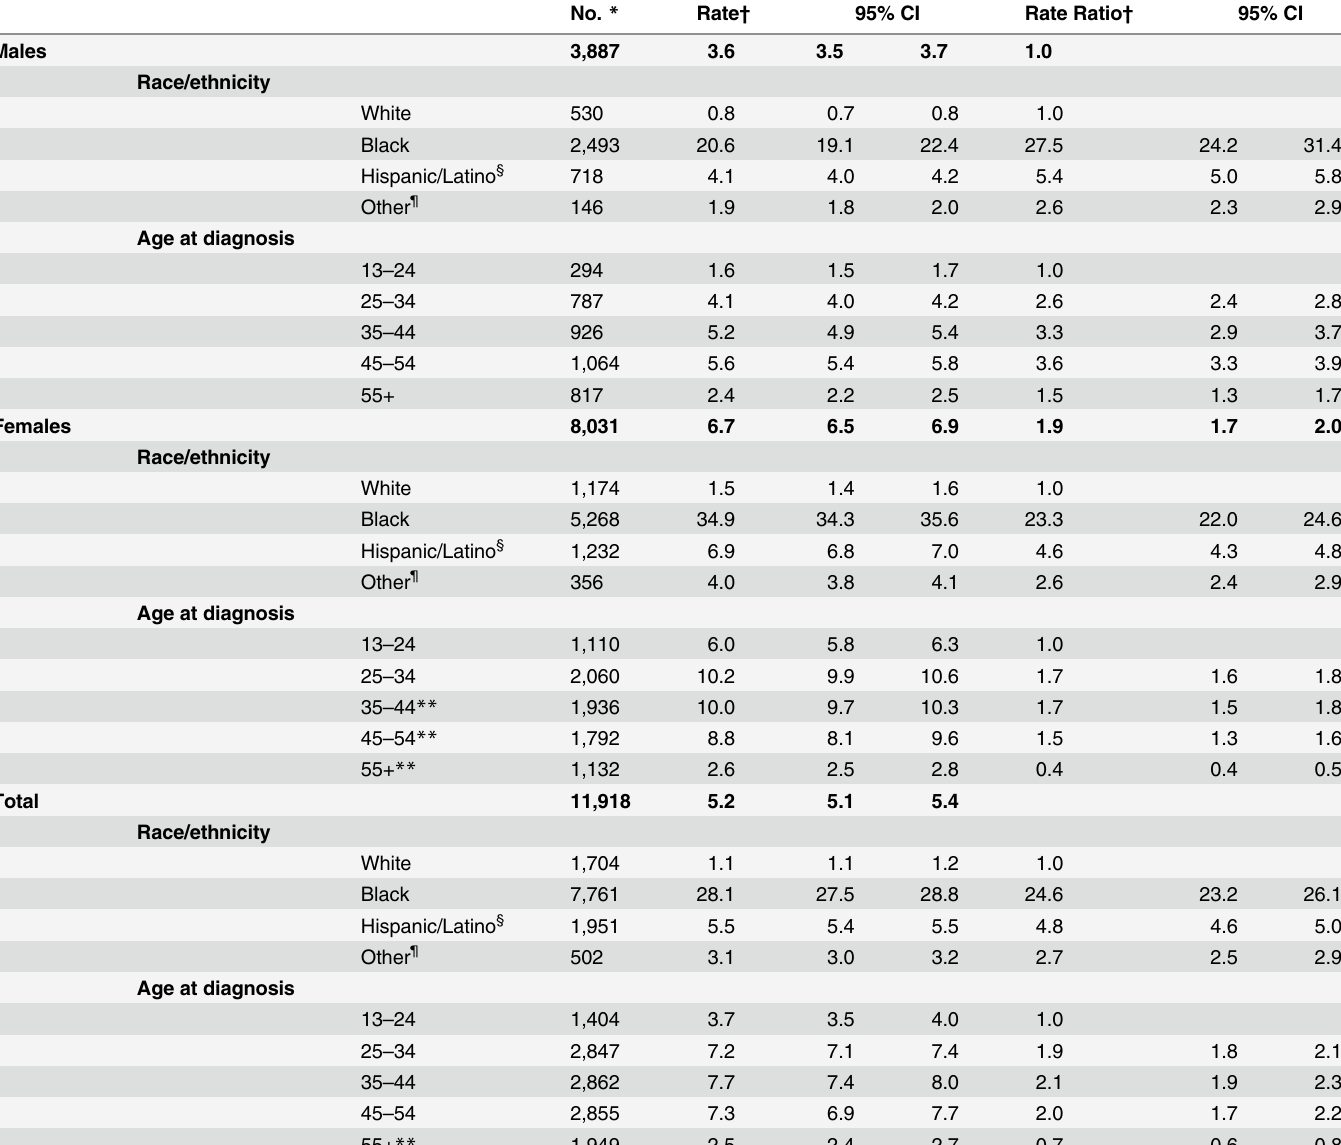
Table 4. Diagnoses of HIV infection among adult and adolescent heterosexuals, by selected characteristics — United States, 2013. Note. Data include persons age 13 years and older with a diagnosis of HIV infection regardless of stage of disease at diagnosis. CI = confidence interval No. * Rate † 95% CI Rate Ratio † 95% CI Males 3,887 Race/ethnicity White